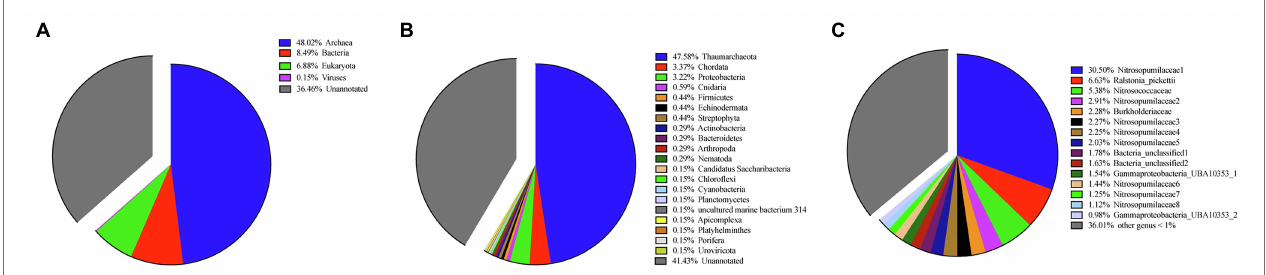
FIGURE 1 | Taxonomy and quantification of metagenome assemblies at the (A) kingdom and (B) phylum level. (C) Taxonomy and quantification of 16S rRNA operational taxonomic units (OTUs) at family level.